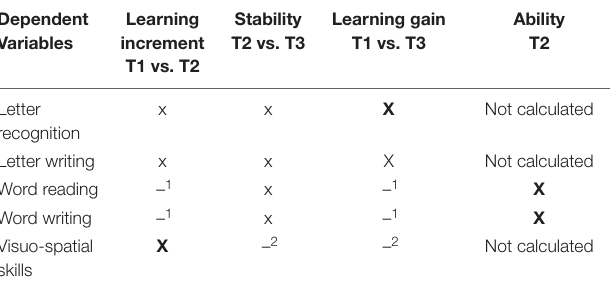
TABLE 2 | Overview of the calculated models (x, X ).